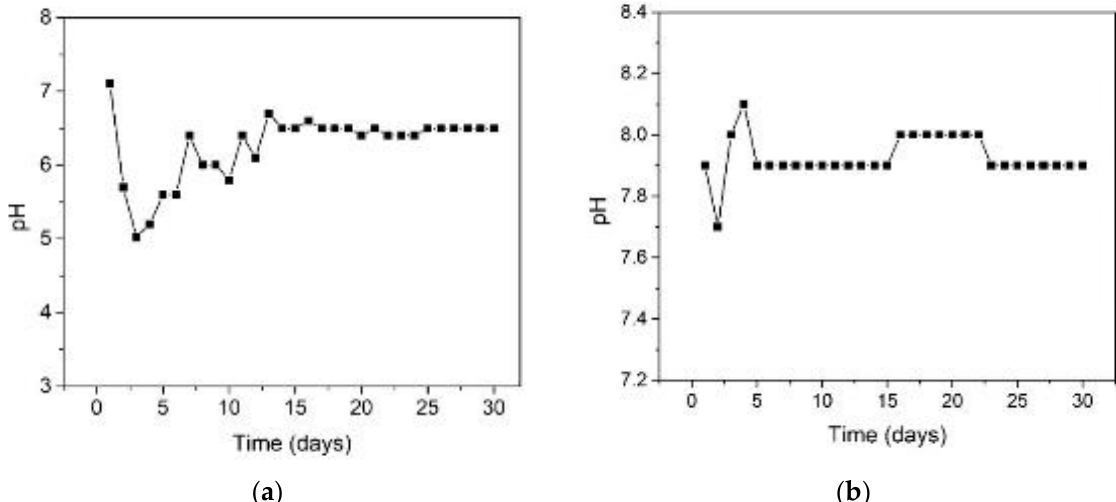
Figure 3. Time variation of the pH during the process for the first ( a ) and for the second batch used inside the bioreactor ( b ).